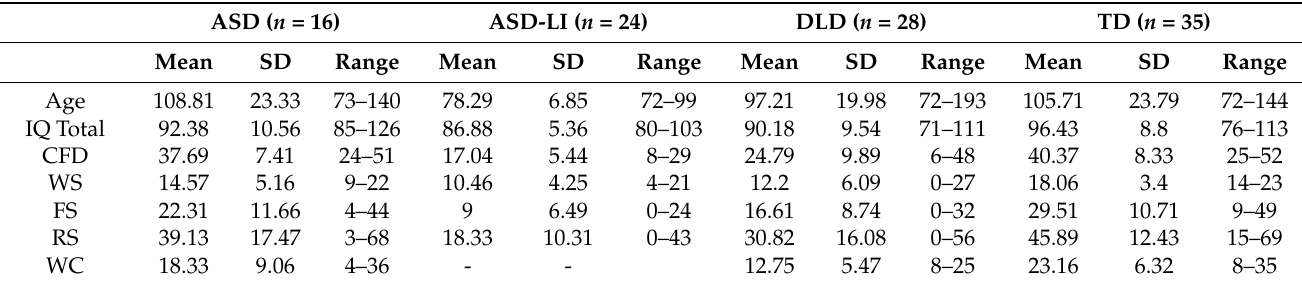
Table 2. Descriptive statistics of group